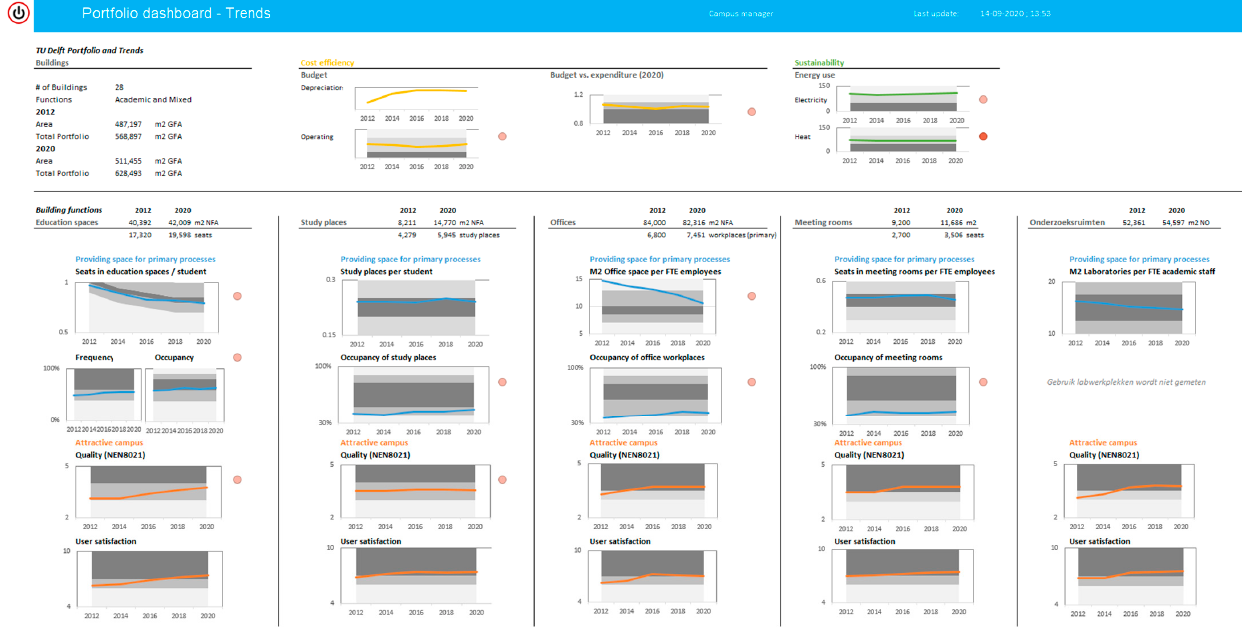
Figure A2. Drilldown dashboard ‘Study places Radboud University’ (tested in workshop 2).